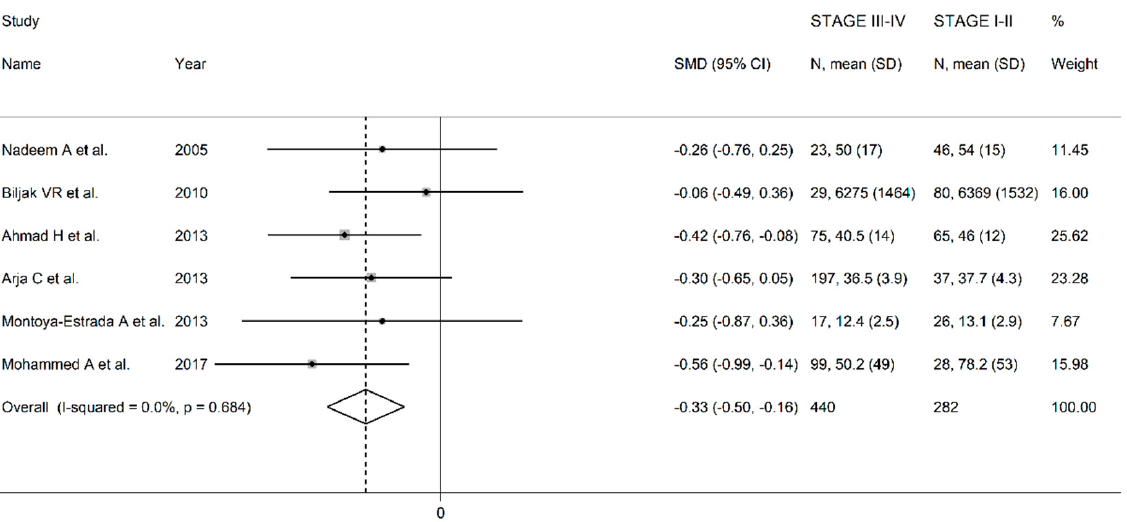
Figure 6. Forest plot of studies examining erythrocyte GPx concentrations of COPD patients in stage I-II vs stage III-IV .